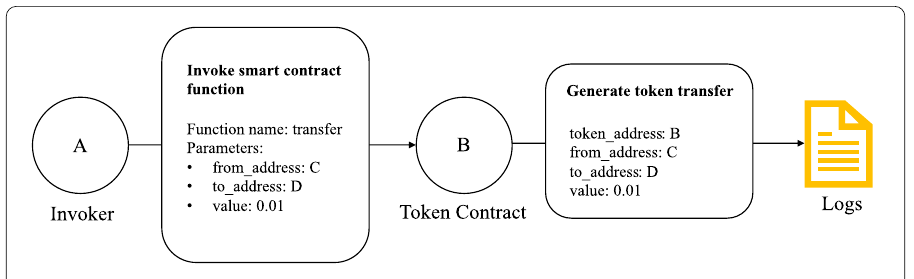
Figure 1 A schematic of ERC20 token transaction. An invoker, i.e., token sender, calls the transfer function in a token contract and passes three parameters, i.e., from_address , to_address , and value . This transaction is recorded on the blockchain if valid. The timestamp of the transaction is the height of the block in which it is logged. Addresses A and C are usually